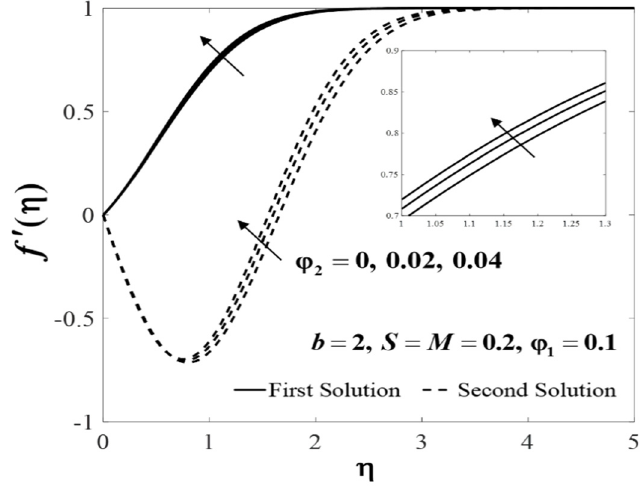
Figure 10. Impact of ϕ 2 on f (cid:48) ( η ) .